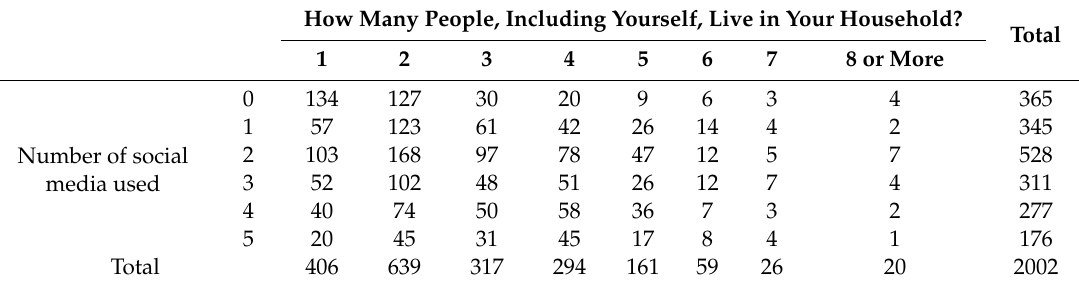
Table 4. Number of social media used by number of people in the